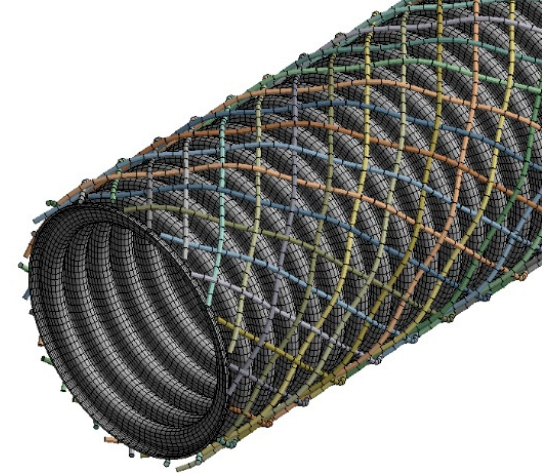
Figure 9. Finite element model.